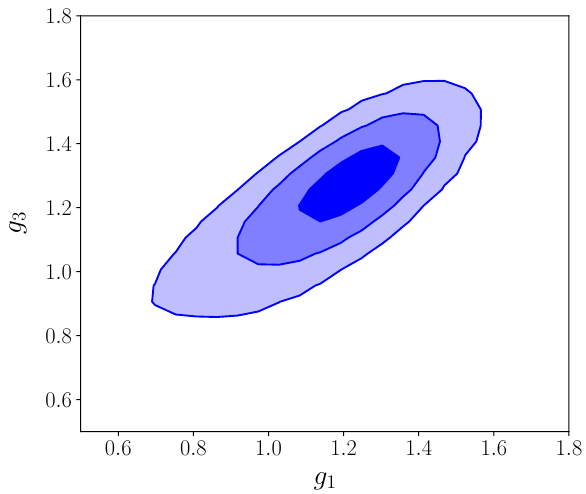
Figure 1 . Fit results for the parameters g 1 and g 3 in Benchmark I ( g R = 0 ). The shaded areas, from darker to lighter blue, describe the 1 , 2 and 3 σ regions,